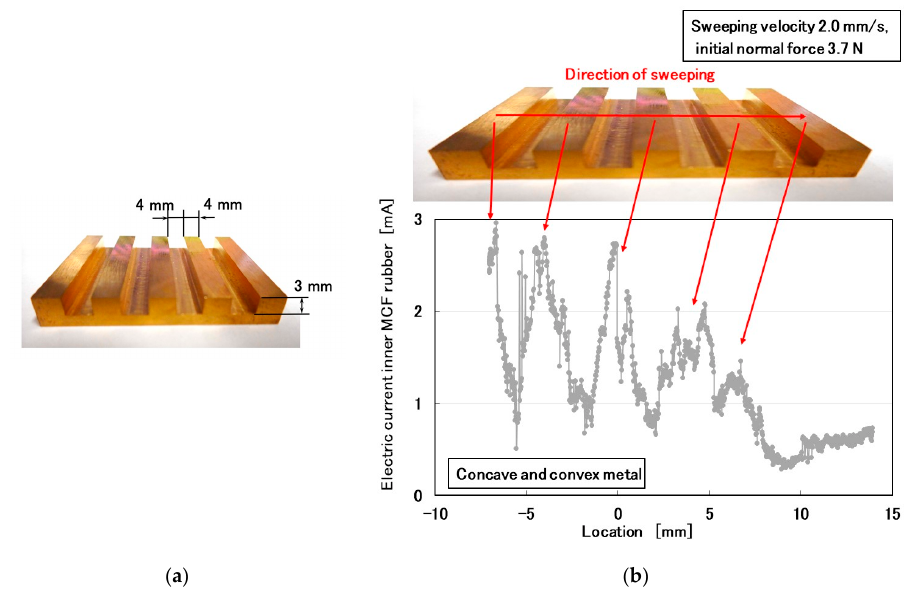
Figure 20. In the case of rubbing a large convexo-concave body by the MCF rubber sensor: ( a ) image of the body; ( b ) surface roughness of the